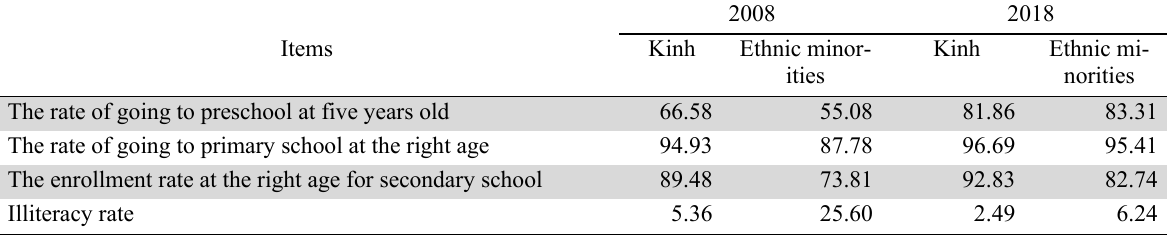
2008 2018 ities